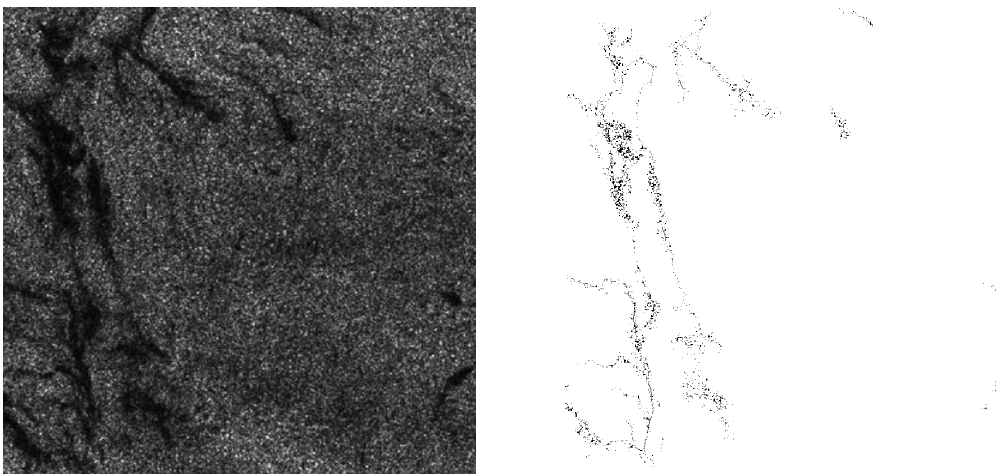
Figure 6. The proposed fast level set method with multiple seeds for initialization of level sets.